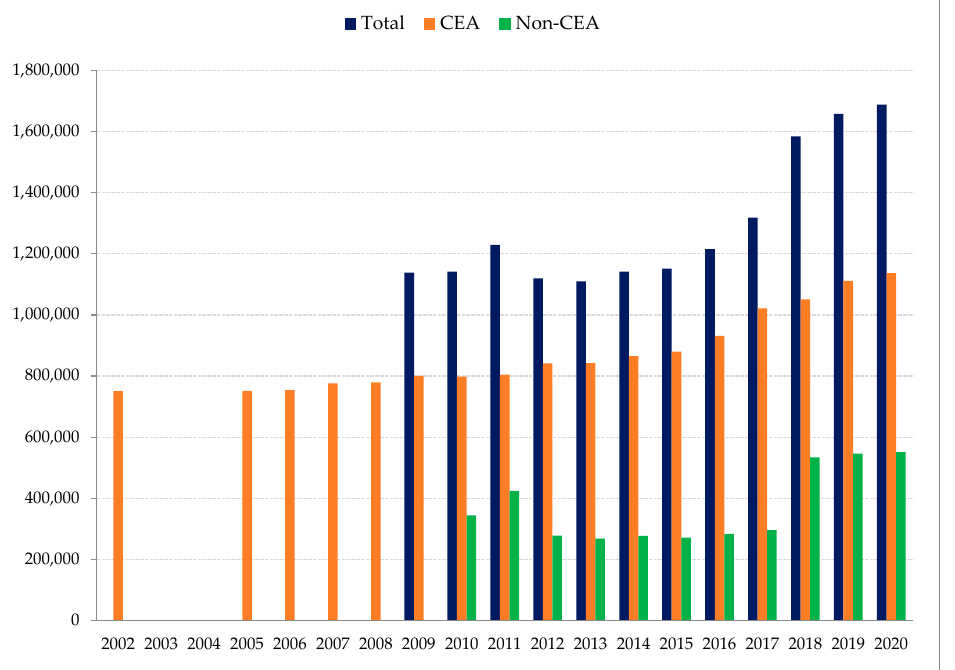
Figure 6. Yearly number of residential earthquake policies from 2002 to 2020. Elaboration of the authors of this article from the CEA data [49,50]. For the period before 2009, the data refer only to the CEA subscriptions. Data for 2003 and 2004 are not available in the sources consulted.